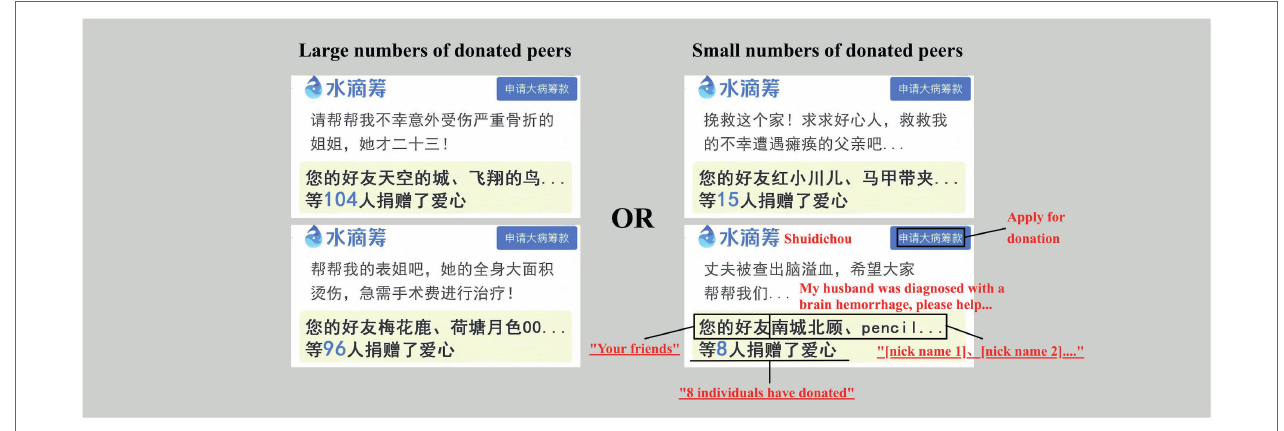
FIGURE 1 | Demonstration of stimulus photos in the two conditions (the large vs. small number of donated peers). Four schematic diagrams were showed, with two of them corresponding to the condition of large number of donated peers (left two photos) and two of them corresponding to the condition of small number of donated peers (right two